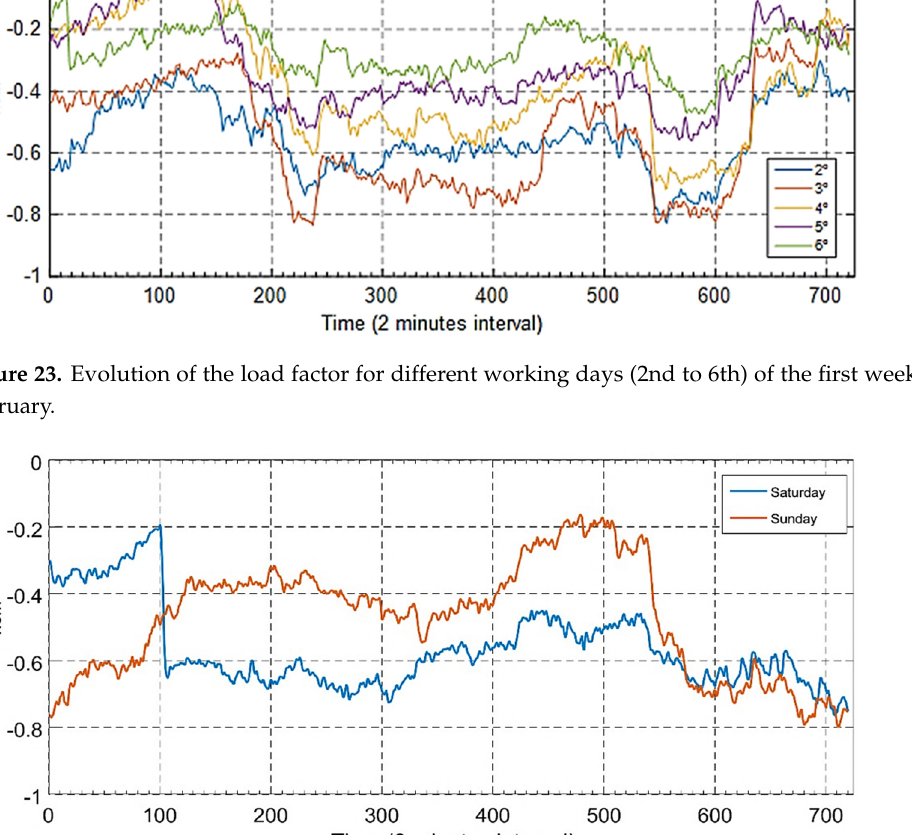
Figure 24. Evolution of the load factor for weekend days of the first week of February.